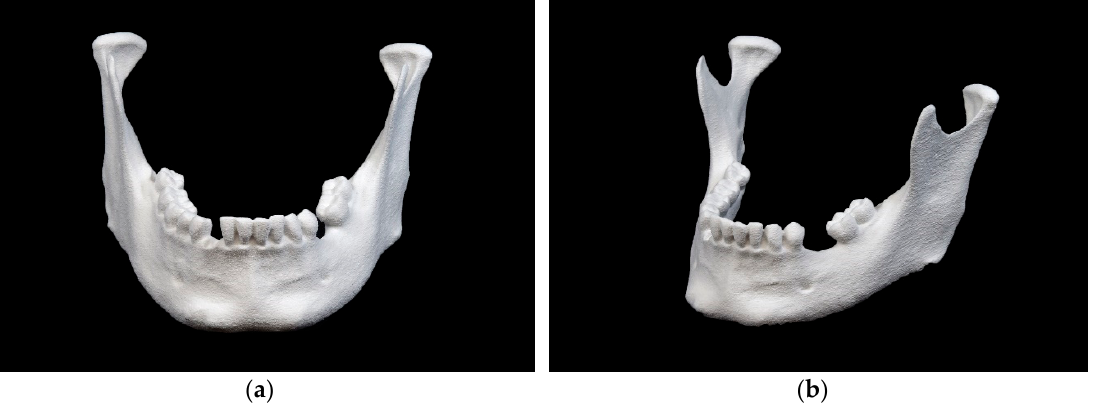
Figure 7. Mandibular model printed in binder jetting (BJ) technology: ( a ) front view; ( b ) side view.